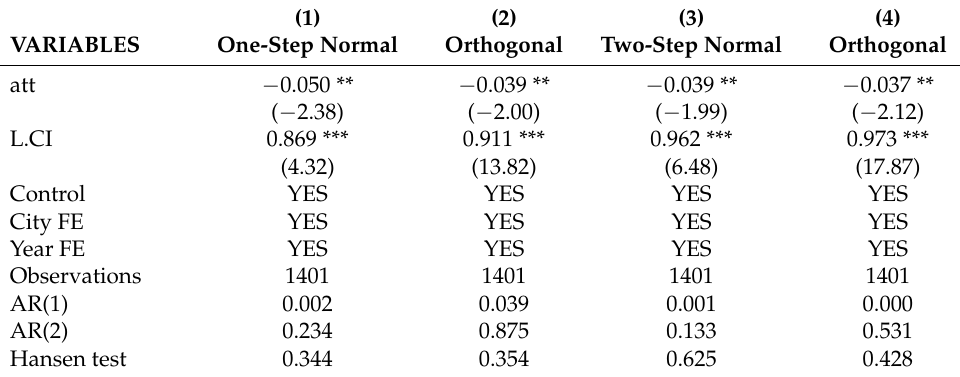
Table 6. Estimation results of the system GMM for CI.